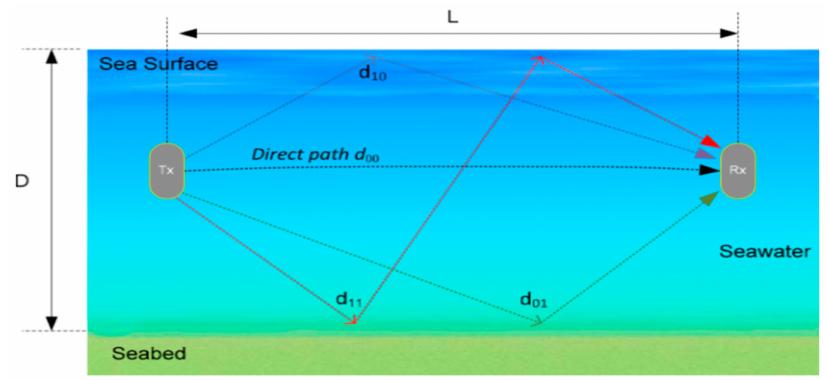
Figure 16. Ray tracing for the representation of multipath channel